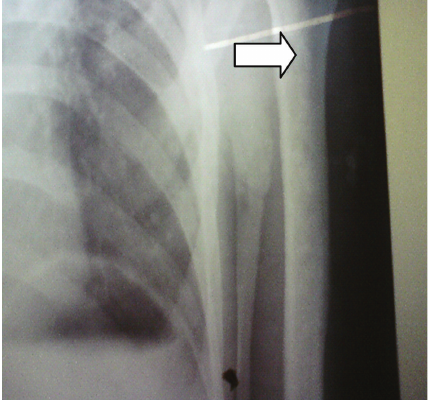
Figure 1: Clinical photograph of the patient showing multiple atypical neurofibromas of left lower limb (shown by arrow). Figure 2: Chest radiograph showing osteosclerotic metastatic lesions in the upper end of humerus (white